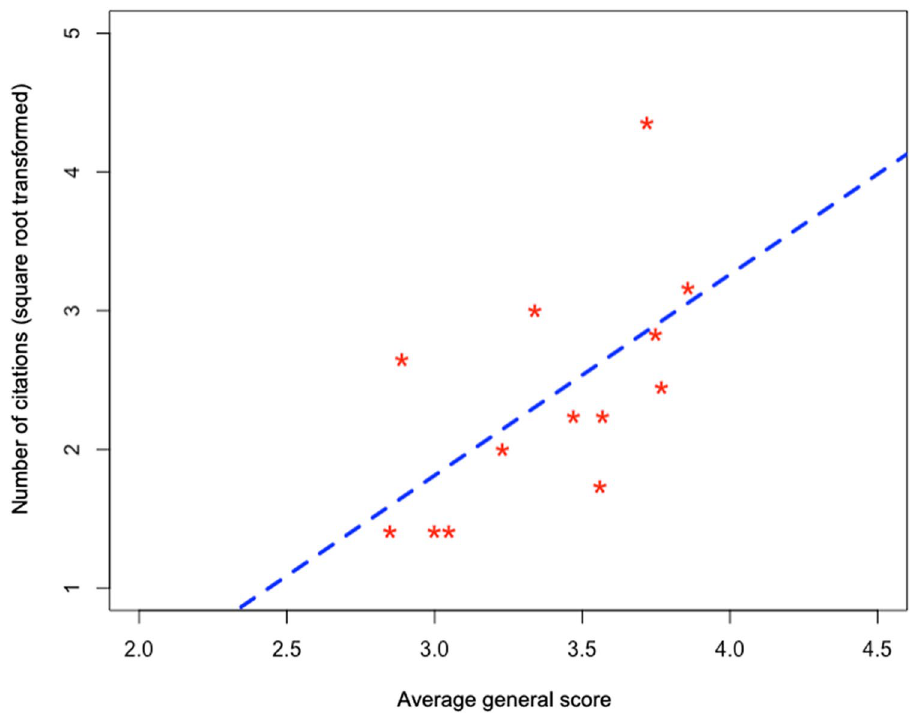
Figure 4. Relationship between the number of citations of wild food plants (transformed by means of square root) and the general average score of these species considering all the attributes measured according to the local perception of the residents of the rural settlement Dom Helder Câmara, in the municipality of Murici, Alagoas state, northeastern